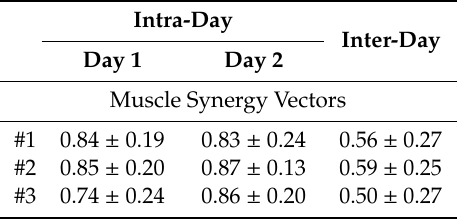
Table 3. Intra- and inter-day similarity values ( r ) of muscle synergy